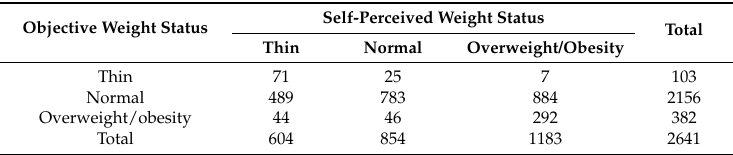
Table 2. Relationships between objective and self-perceived weight status ( N = 2641).